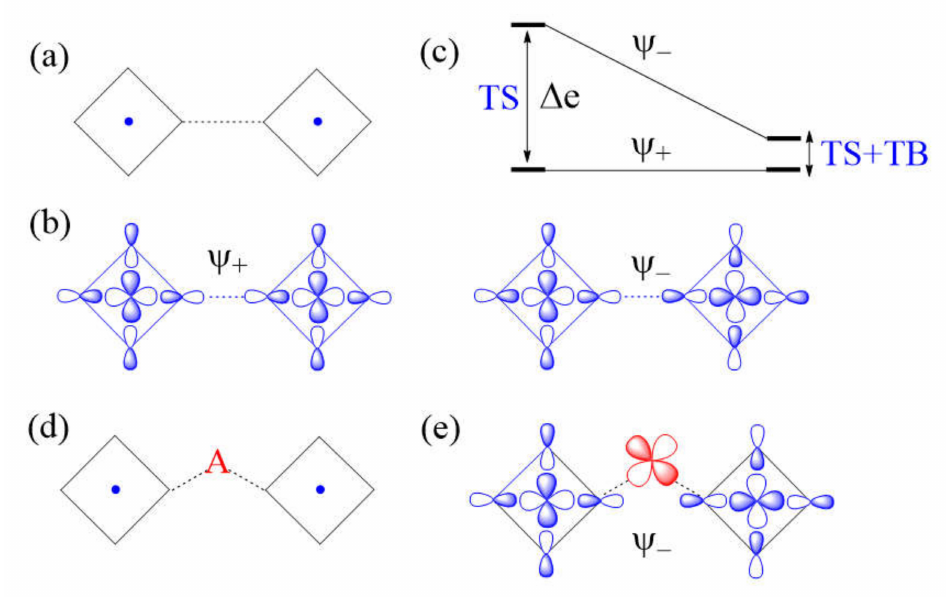
Figure 8. ( a ) A case of strong Cu–L . . . L–Cu spin exchange where the two Cu–L bonds leading to the L . . . L contacts are linear. ( b ) The in-phase and out-of-phase combinations ( Ψ + and Ψ − , respectively) of the two magnetic orbitals, resulting from the through-space (TS) interactions. ( c ) The energy split ∆ e between Ψ + and Ψ − is large when the overlap between the p-orbital tails is large. ( d ) A Cu–L . . . A . . . L–Cu exchange generated when the L . . . L contact is bridged by a d 0 metal cation A. ( e ) The bonding interaction of the Ψ − state with the d π orbital of A. ( f ) The large energy split ∆ e resulting from the through-space (TS) interaction in the Cu–L . . . L–Cu exchange becomes small in the Cu–L . . . A . . . L–Cu exchange as a result of the through-bond (TB) interaction that occurs primarily with the Ψ −